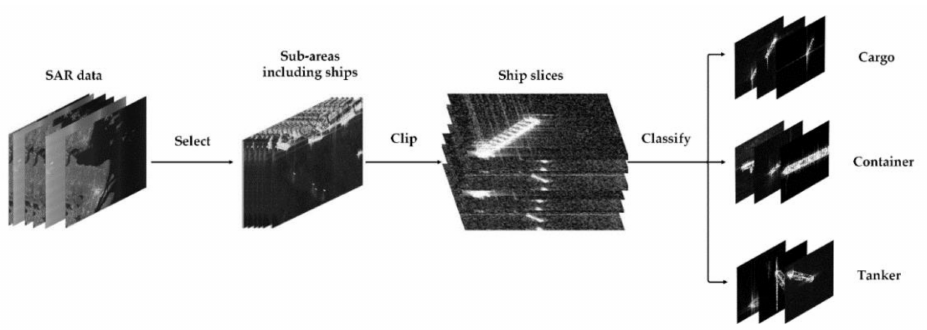
Figure 3. The method of creating high-resolution synthetic aperture radar (SAR) ship slices [61].